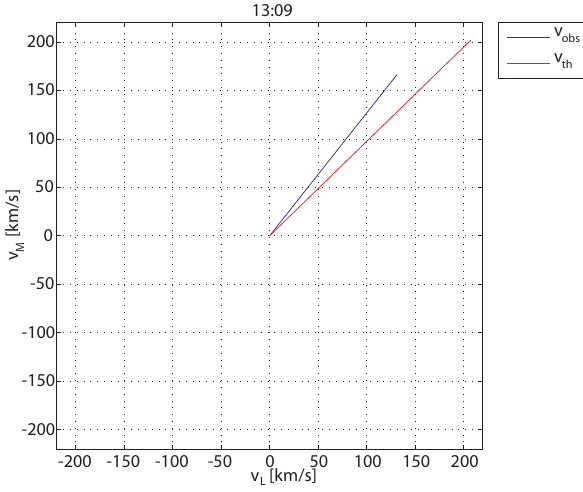
Fig. 5. Results of the Wal´en test for the event at 13:09UT. The outflow region is observed for more than 10s and the result indicate that reconnection is ongoing sunward of the spacecraft. The blue line corresponds to the observed velocity and the red line to the calculated